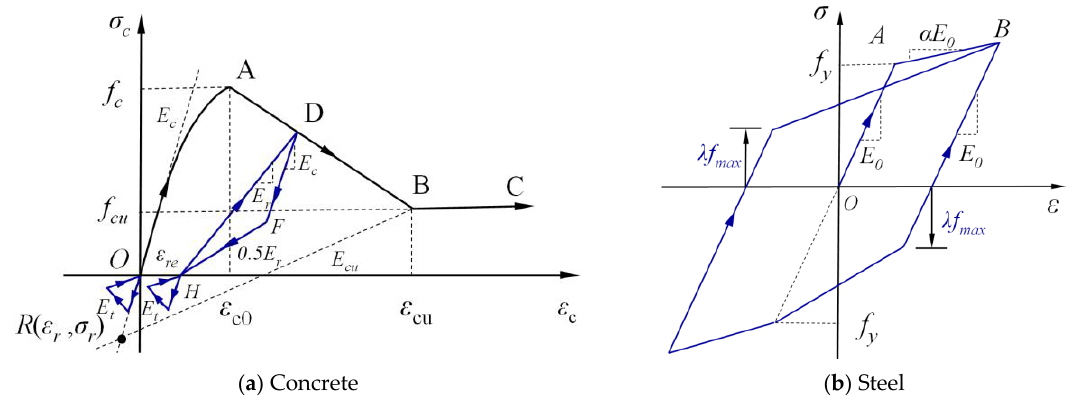
Figure 6. Constitutive models and equivalent method for steel reinforcement.